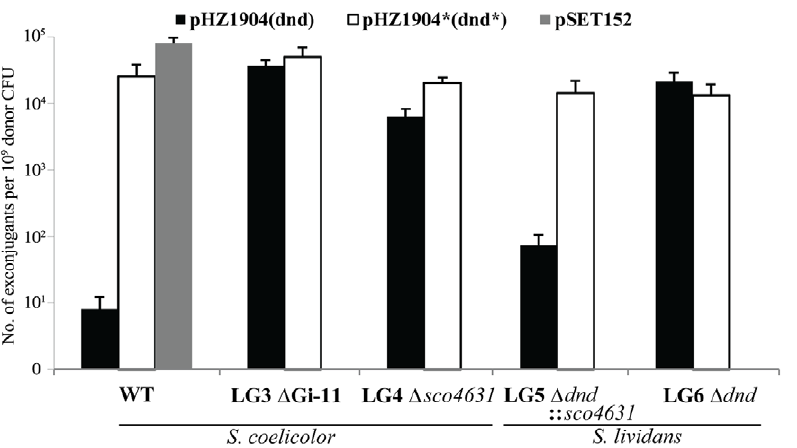
Figure 2. Restriction of plasmids expressing the dndA-E gene cluster by Streptomyces strains containing sco4631 . Graph showing the number of apramycin resistant S. coelicolor (1–3) and S. lividans (4 and 5) exconjugants that were obtained in matings with E. coli ET12567/pUZ8002 containing mobilizable ( oriT ) plasmids. WT, plasmid-free, wild-type S. coelicolor M145 strain; LG3, S. coelicolor mutant lacking the entire genomic island Gi11 (= SLP1) which includes sco4631 ; LG4, S. coelicolor mutant from which only sco4631 was deleted; LG5, S. lividans derivative which lacks the dnd gene cluster and contains a cloned copy of the S. coelicolor gene sco4631 ; LG6 S. lividans derivative which lacks the dnd gene cluster. The graph shows that pHZ1904 which contains the dndA-E gene cluster (causes DNA S-modification; black bars), is specifically restricted by the wild type S. coelicolor strain. pHZ1904* (white bars), which differs from pHZ1904 by an inactivating frame shift point mutation in dndE , was not restricted. The cloning vector pSET152 without insert (grey bar) served as an additional, not restricted control.